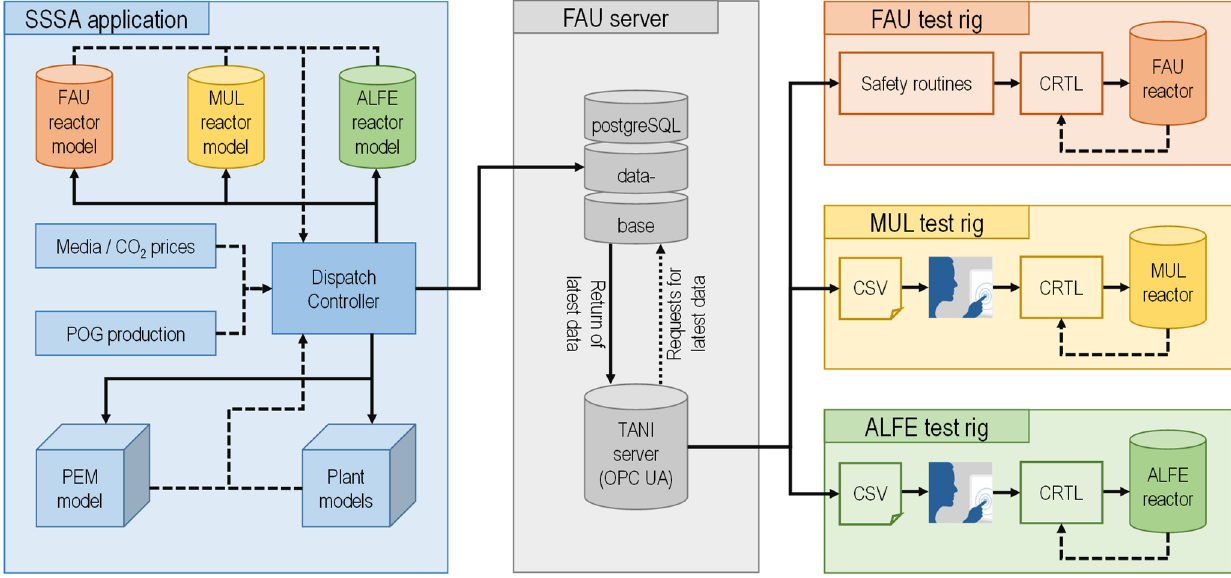
Figure 7. Data communication structure between DC and test rigs for online test campaign.